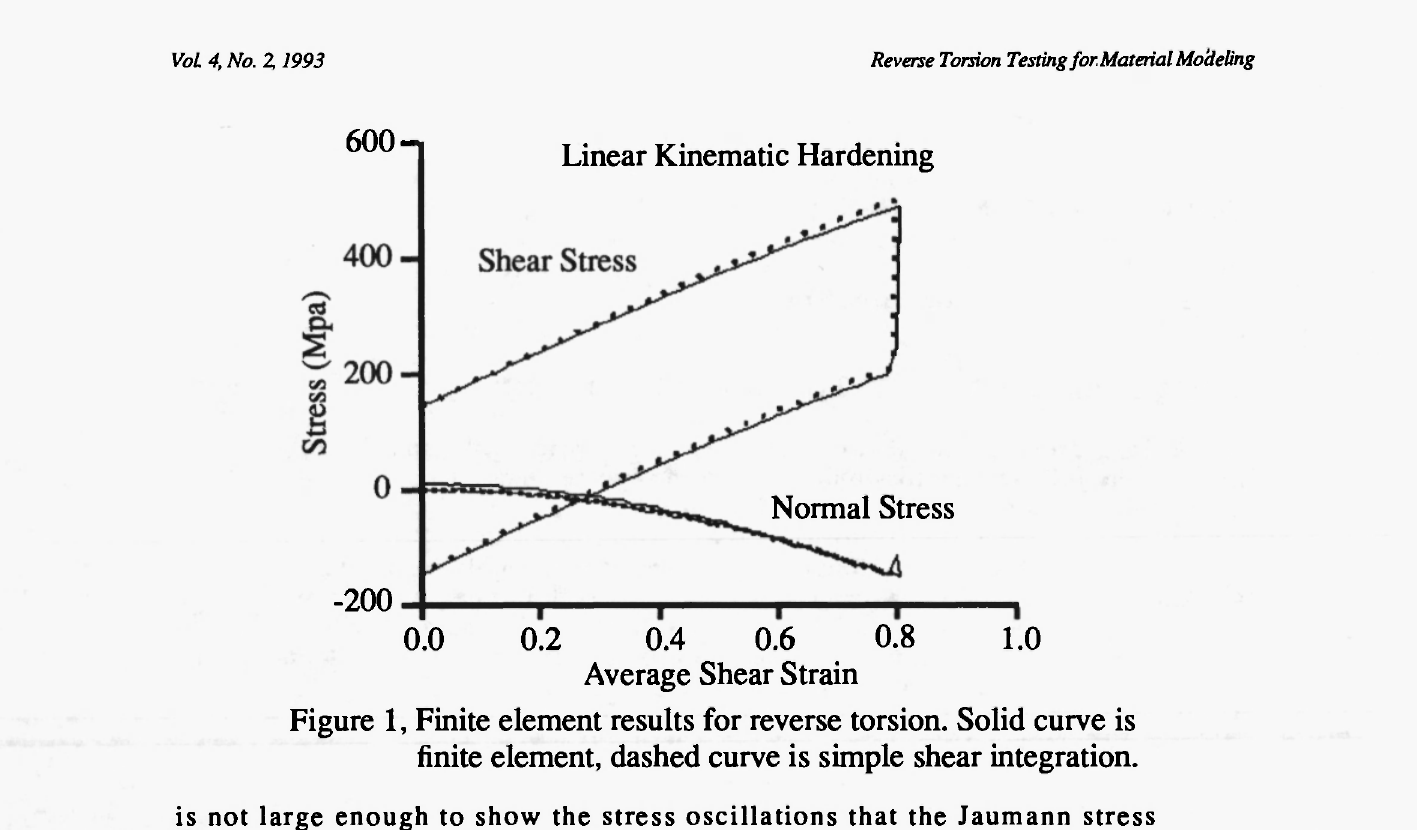
Figure 1, Finite element results for reverse torsion. Solid curve is finite element, dashed curve is simple shear